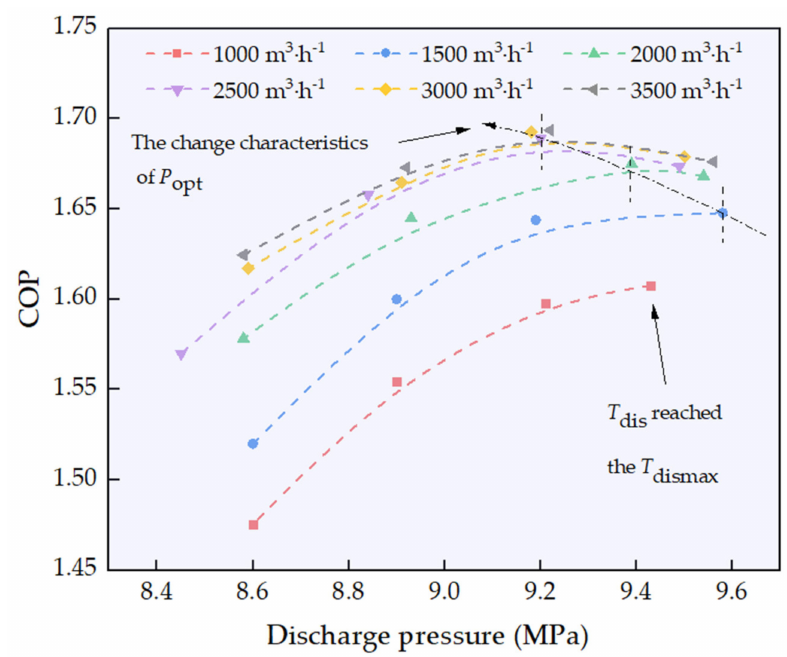
Figure 7. Influence of discharge pressure on COP at gas cooler air volume flow rates between 1000 m 3 · h − 1 and 3500 m 3 · h − 1 .